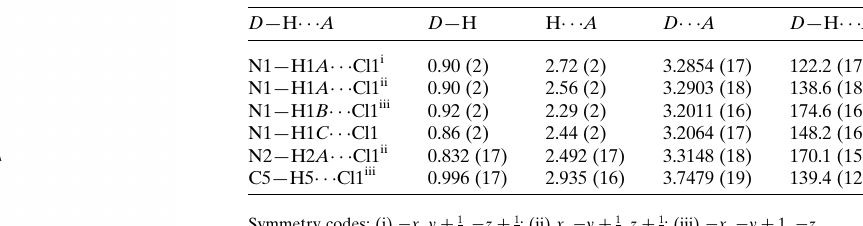
Table 2 Experimental details.